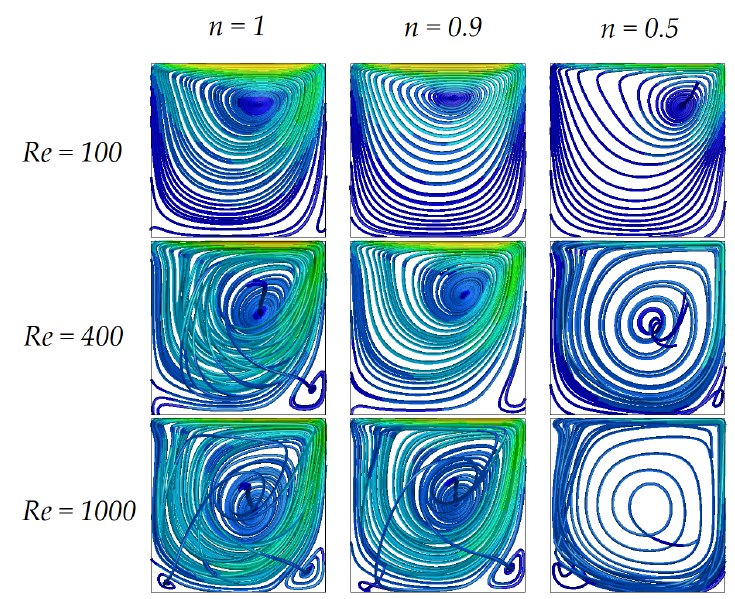
Figure 9. Flow streamlines coloured by velocity magnitude in central x – y plane of Ω for the three different Re numbers as well as three different n values.